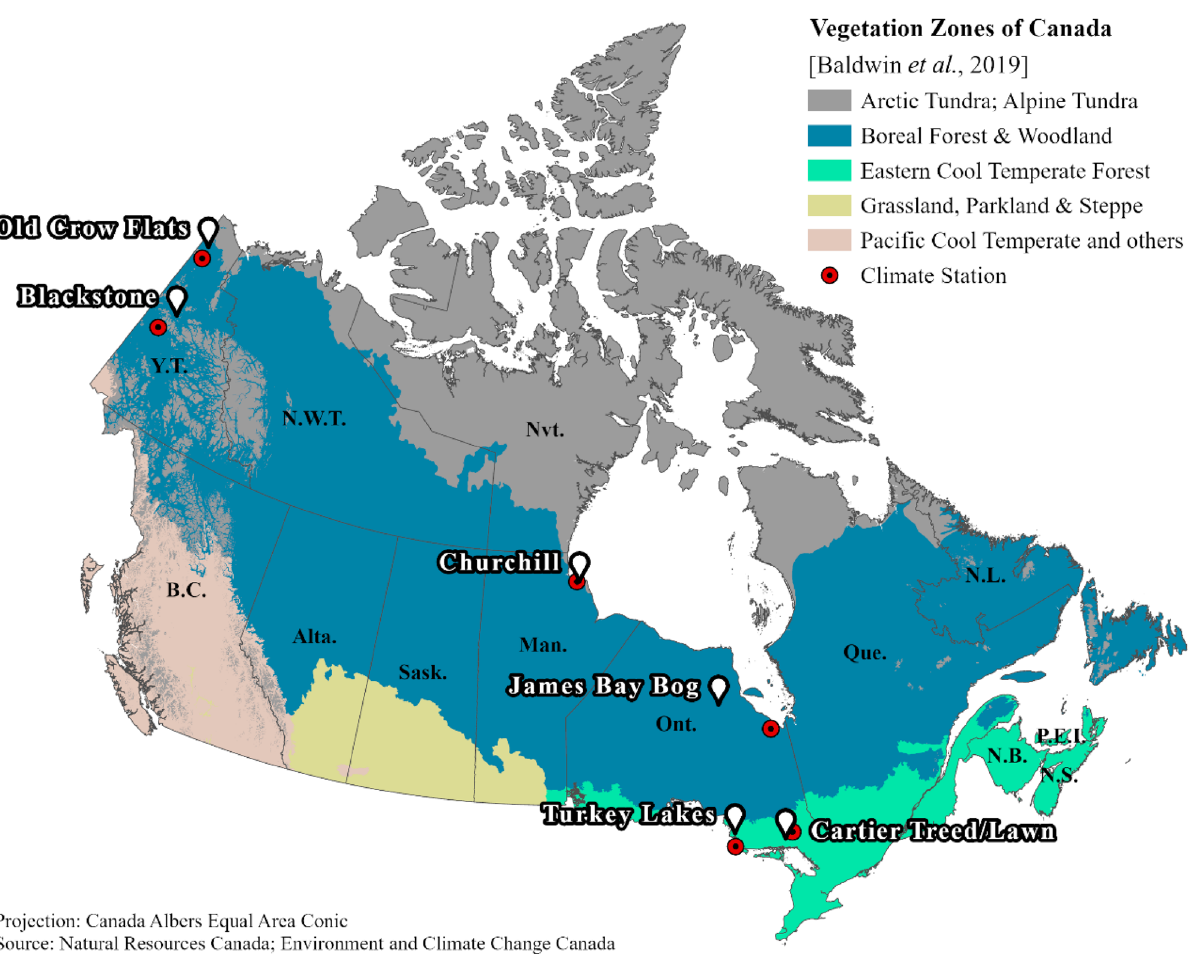
Figure 1. The locations of peatland sites across different vegetation (ecoclimate) zones of Canada (Baldwin et al . 2019) with the nearest weather stations (circles) for which Canadian Climate Normals 1981–2010 data are available (Environment and Climate Change Canada). The map was created using ArcGIS Pro (Esri). The site names correspond to the information given in Table